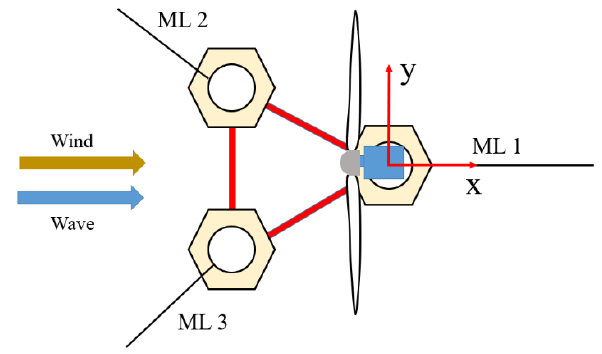
Figure 7. Mooring configuration of the WindFloat SFOWT.